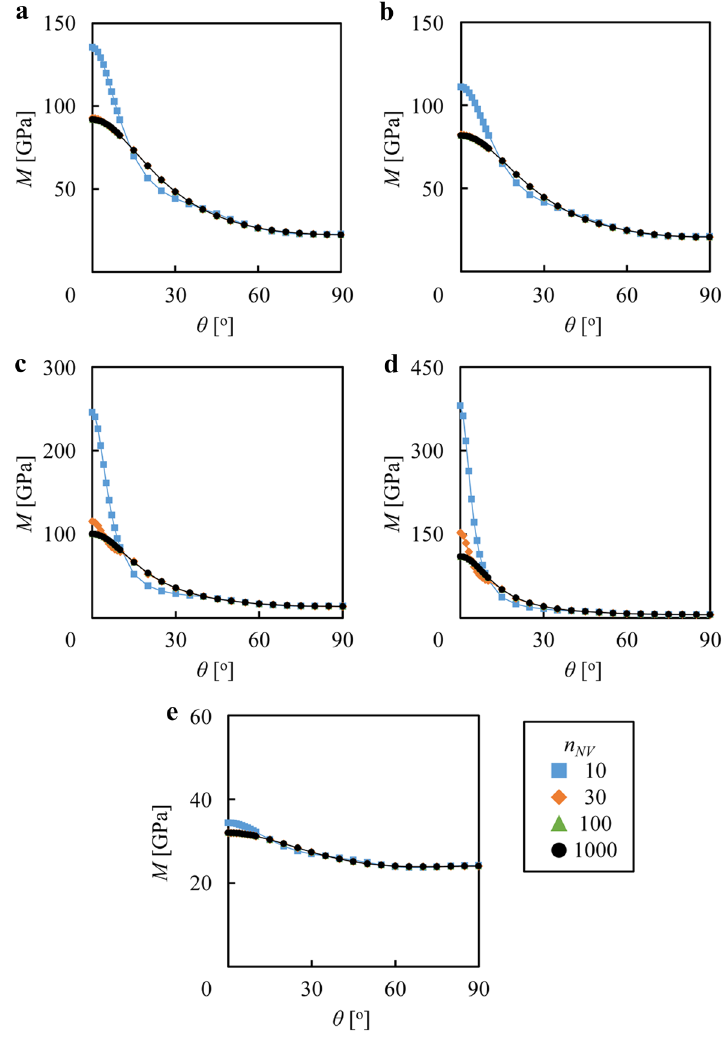
Fig. 3 Indentation-derived elastic modulus ( M ) at various tilt angles ( θ ) and subinterval numbers ( n ) calculated using VN the Vlassak–Nix model for commercially available